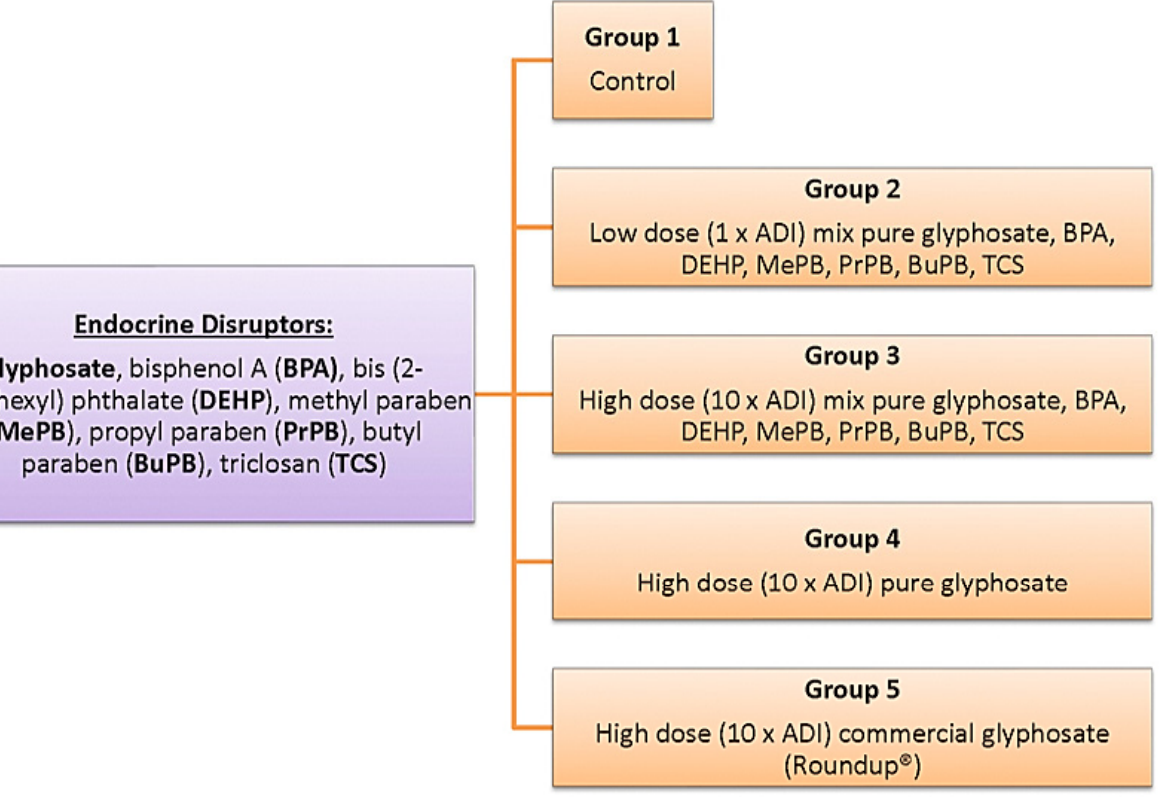
Figure 1. Groups of administration (substances-doses). ADI: Acceptable Daily Intake. The low dose of the administered solution will contain an amount of each compound equal to its ADI (1 × ADI), while the high dose will contain ten times the ADI (10 × ADI). All animals will be monitored and examined daily for signs of morbidity or